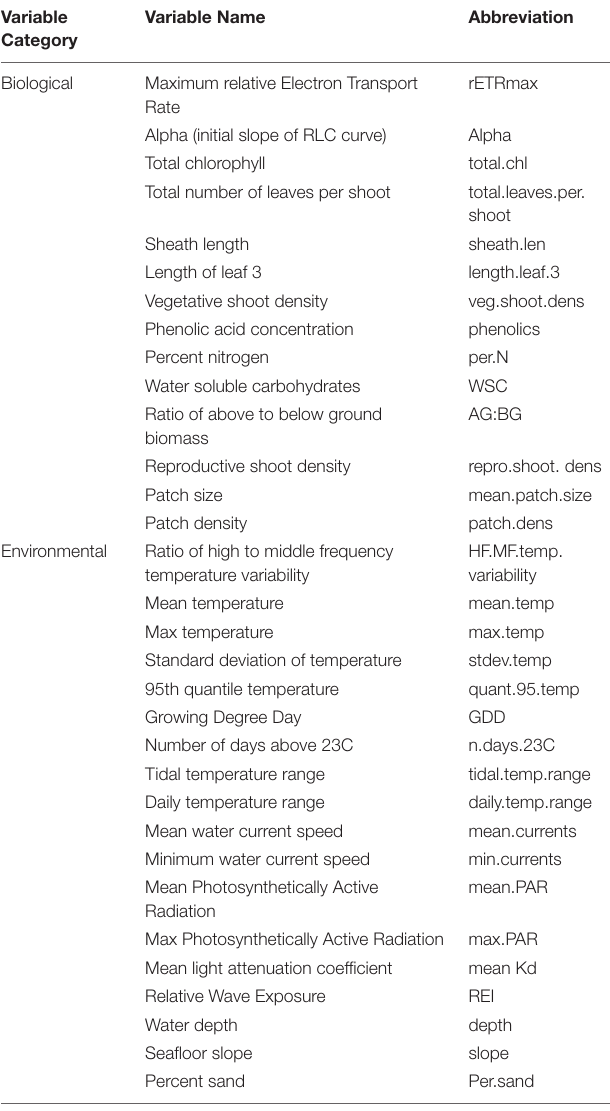
TABLE 1 | Biological and environmental variables, and their abbreviations used throughout the text and